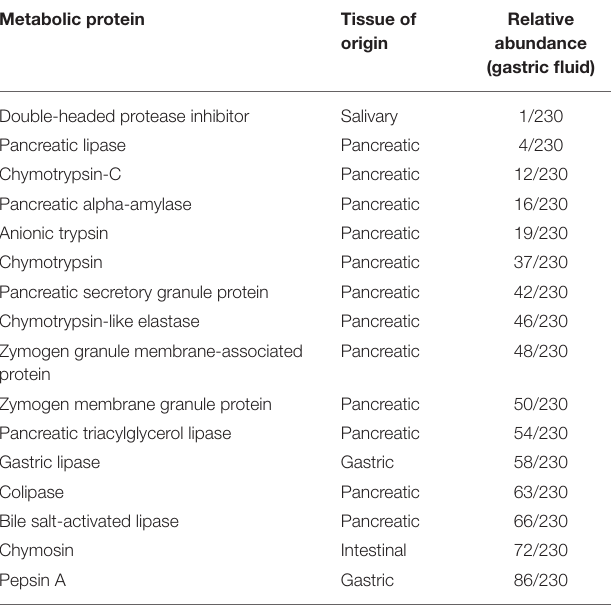
TABLE 2 | Metabolic proteins demonstrating increased abundance (GF vs. normal) and relative abundance in GF based on normalized spectral abundance factors are